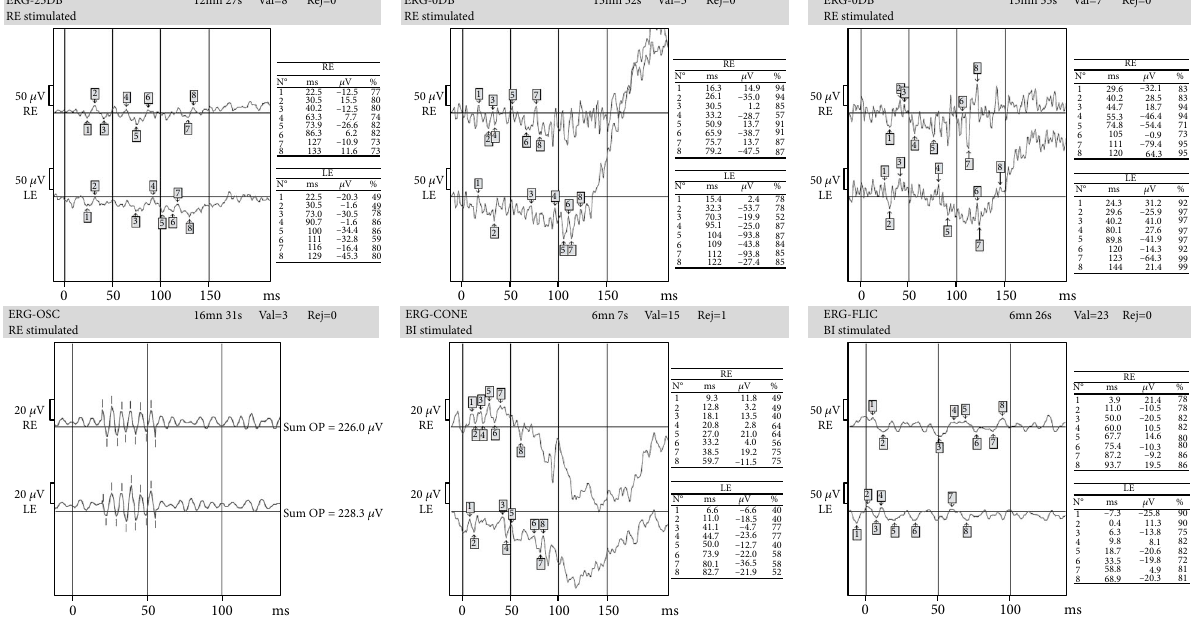
Figure 4: ERG fi ndings. Absence of DA 0.01 ERG response and a DA 10.0 with a diminished a-wave and b-wave. LA 3.0 ERG with a diminished b-wave and absence of LA fl icker 30Hz ERG response. ERG: electroretinography; DA: dark-adapted; LA: